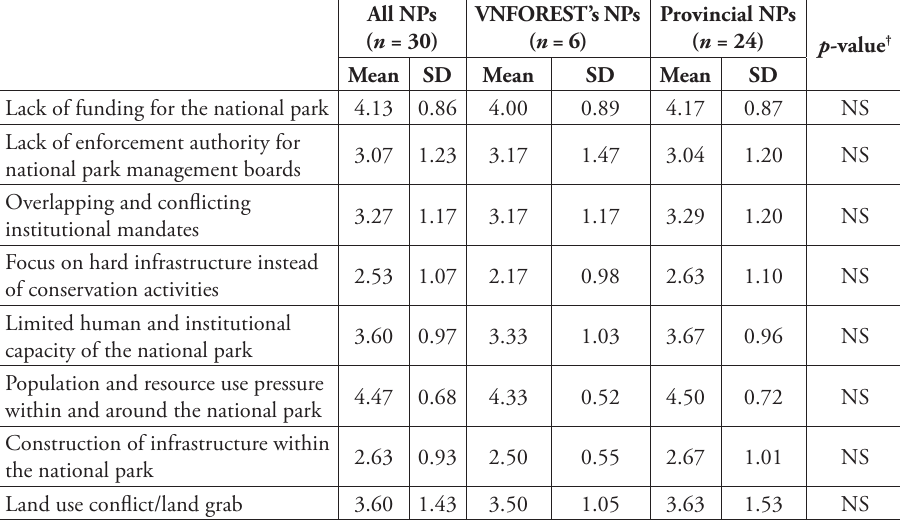
Table 10. Major causes of limited management capacity of national parks, rated from 1 (strongly disa- gree) to 5 (strongly agree), with a score of 3 representing neutral.